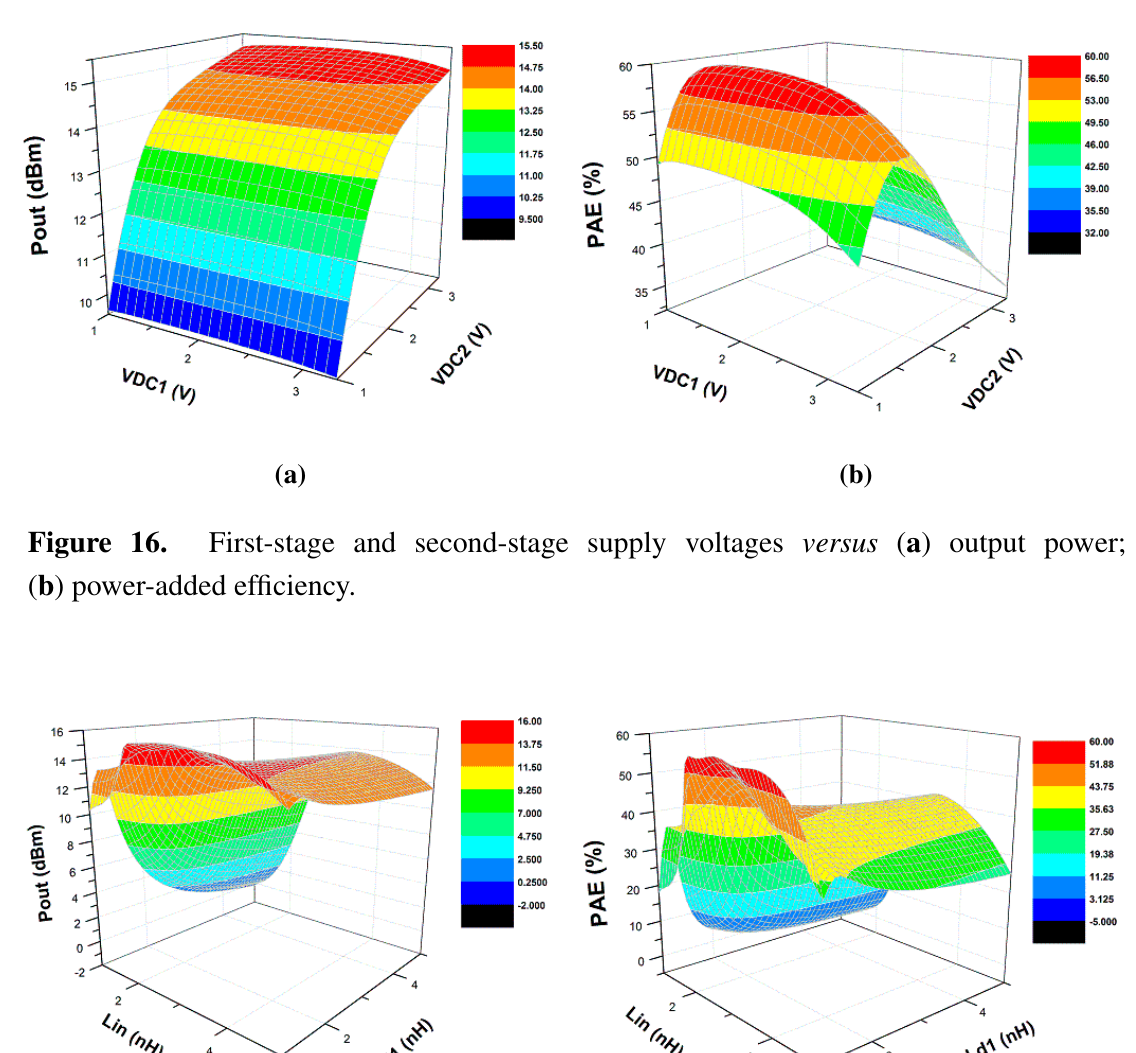
and L ; ( b ) power-added efficiency versus L in d 1